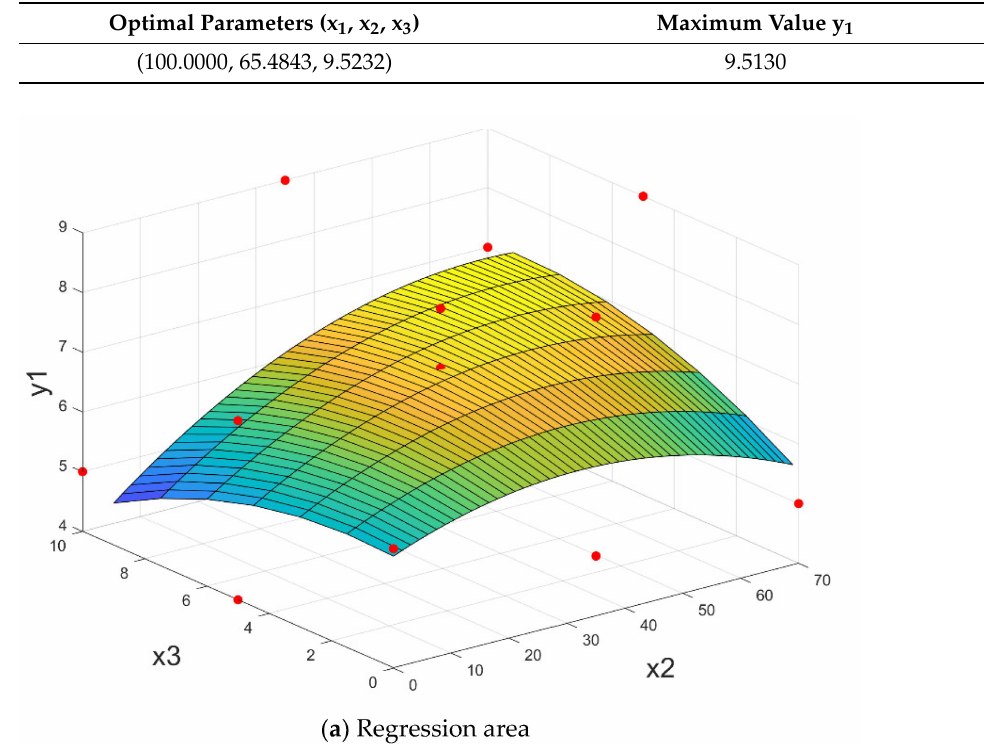
Table 4. The results of the optimization problem for y 1.